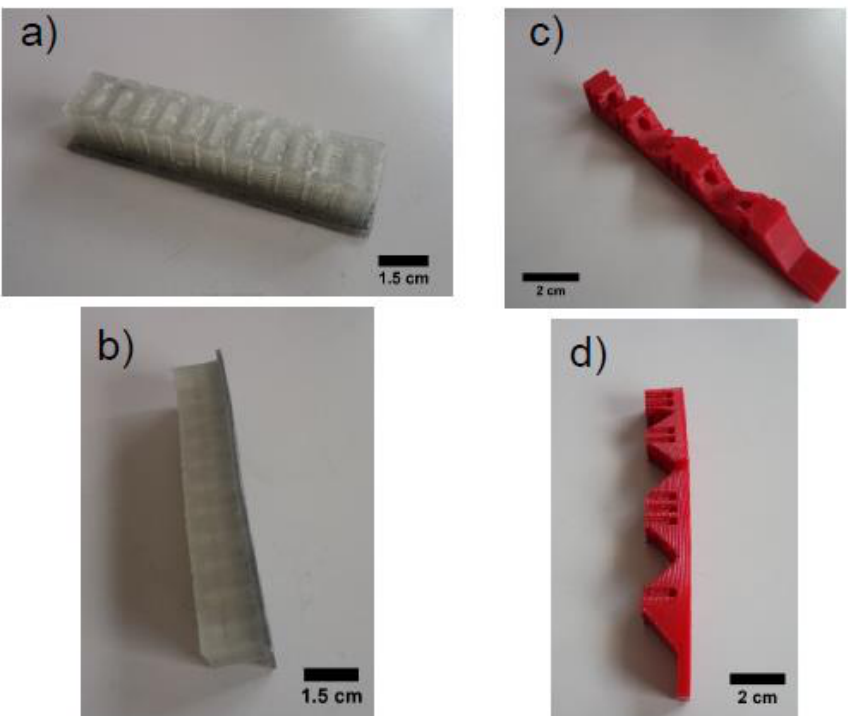
Figure 3. The two bending actuators produced with fused deposition modeling (FDM): a pneumatic bending actuator ( a ) top view and ( b ) side view and a tendon-driven actuator ( c ) top view and ( d ) side view.